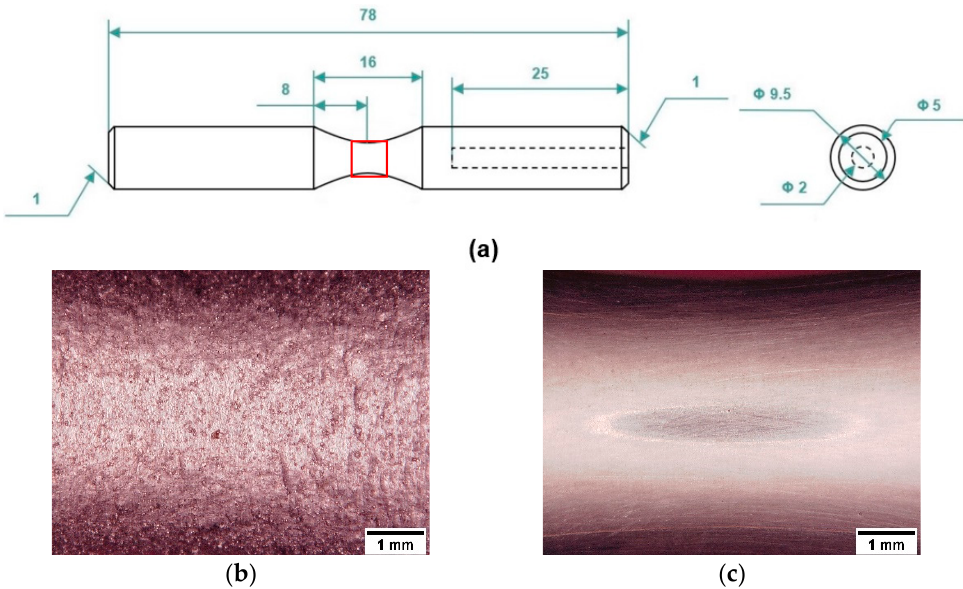
Figure 2. Rotating bending specimen geometry (dimensions in mm), adapted from [16]. Gauge length surface (highlighted by the red box in ( a )) before ( b ) and after ( c ) polishing. The roughness was evaluated on all the tested specimens using stylus profilometry